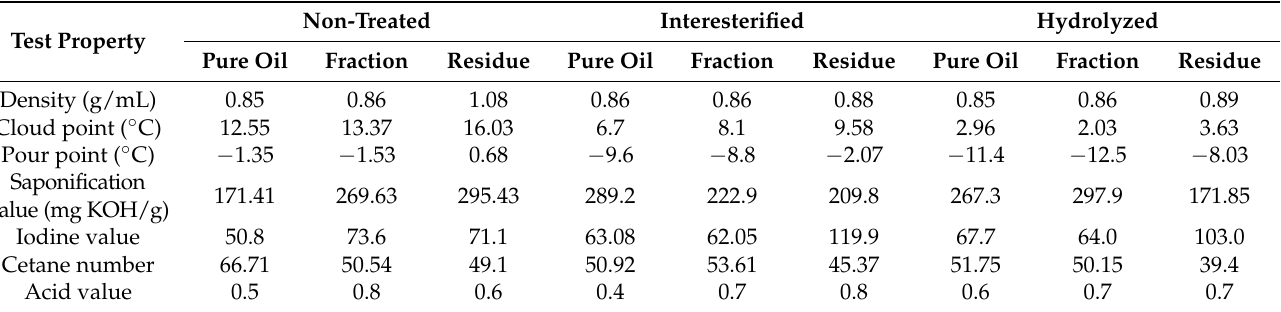
Table 2. Physiochemical properties of biodiesel produced from non-treated/treated pure oil, fraction, and